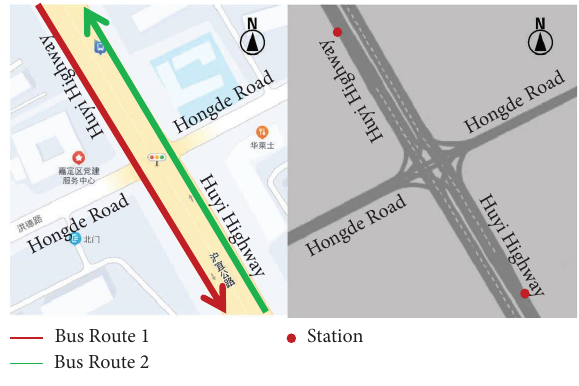
Figure 8: Te study